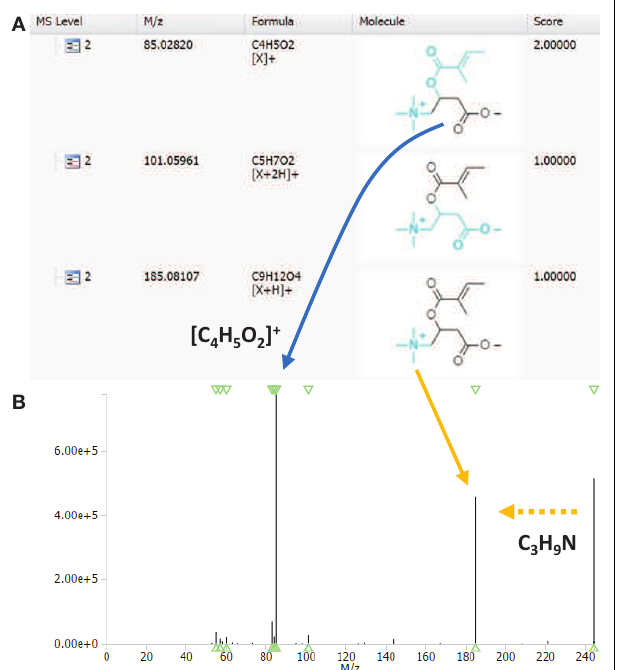
FIGURE 2 | (A) Fragment annotation of HMDB-annotated acylcarnitine with elemental formula C 12 H 21 NO 4 in MAGMa, annotated as tiglylcarnitine (HMDB02366), and (B) merged HCD-MS 2 spectrum of the annotated tiglylcarnitine. Arrows indicate the corresponding mass fragmentation peaks of the neutral loss of trimethylamine (yellow dashed arrow indicates neutral loss in the mass spectrum; the yellow full arrow points to resulting mass fragment) and of the mass fragment C 4 H 5 O 2 (blue full arrow).